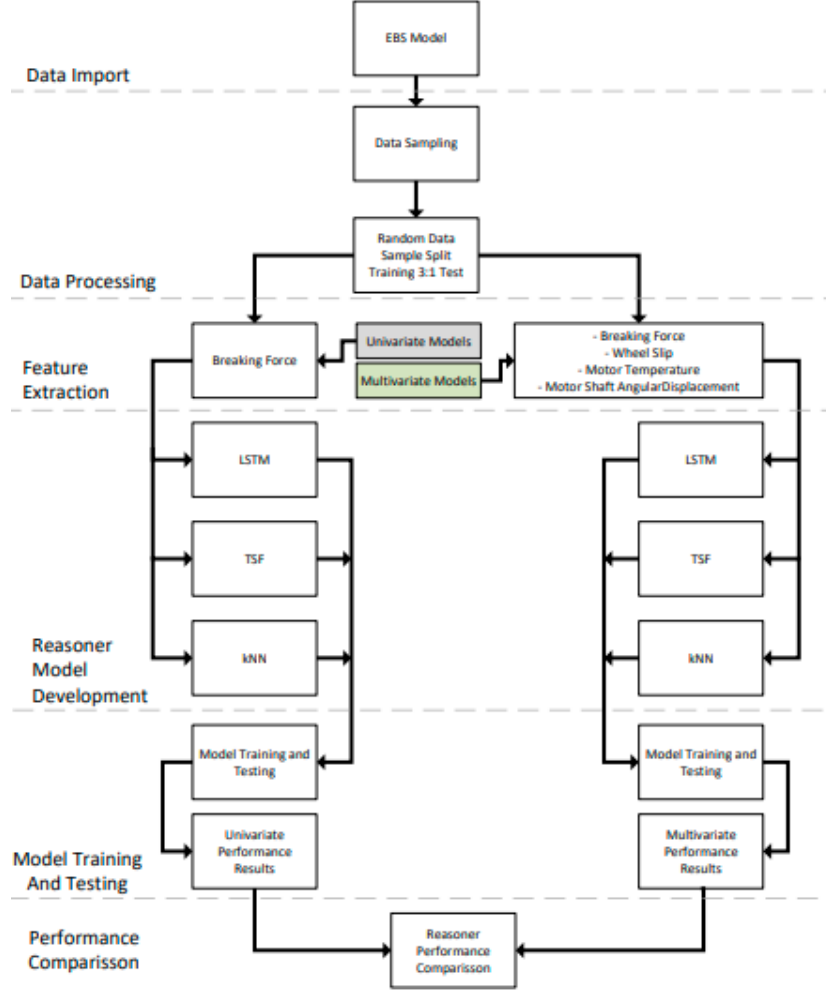
Figure A1 Reasoner Development Flowchart. Figure A1. Reasoner Development